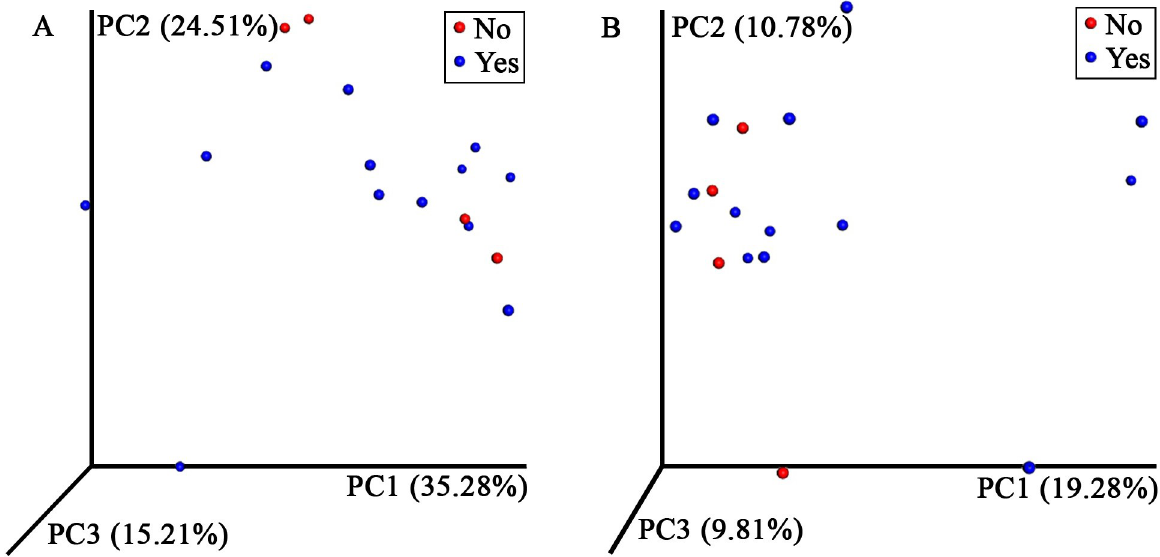
Fig 7. Juvenile green turtle fecal bacterial community composition in individuals on and not on antibiotics. Principle coordinate analysis of weighted (A) and unweighted (B) UniFrac distances of 16S rRNA genes found in feces from juvenile green turtles ( Chelonia mydas ) at admission, demonstrating that there was no significant difference in bacterial community composition between turtles that were (blue, N = 13) and were not (red, N = 4) on antibiotics (A: R = -0.087, p = 0.660; B: R = -0.193, p = 0.890). Each circle represents an individual fecal sample.